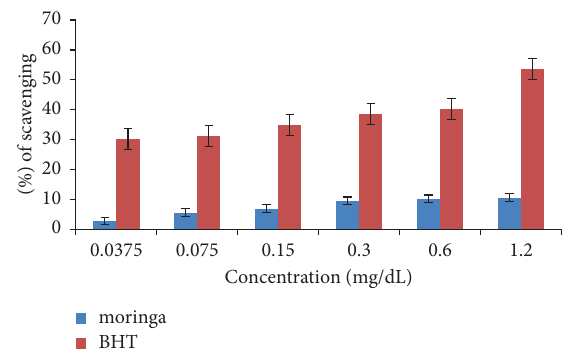
Figure 1: Antioxidant activity of M. oleifera on the ABTS radical. SCV (%) means percentage scavenging activity. Table 3: DPPH and nitric oxide IC 50 values of M. oleifera .